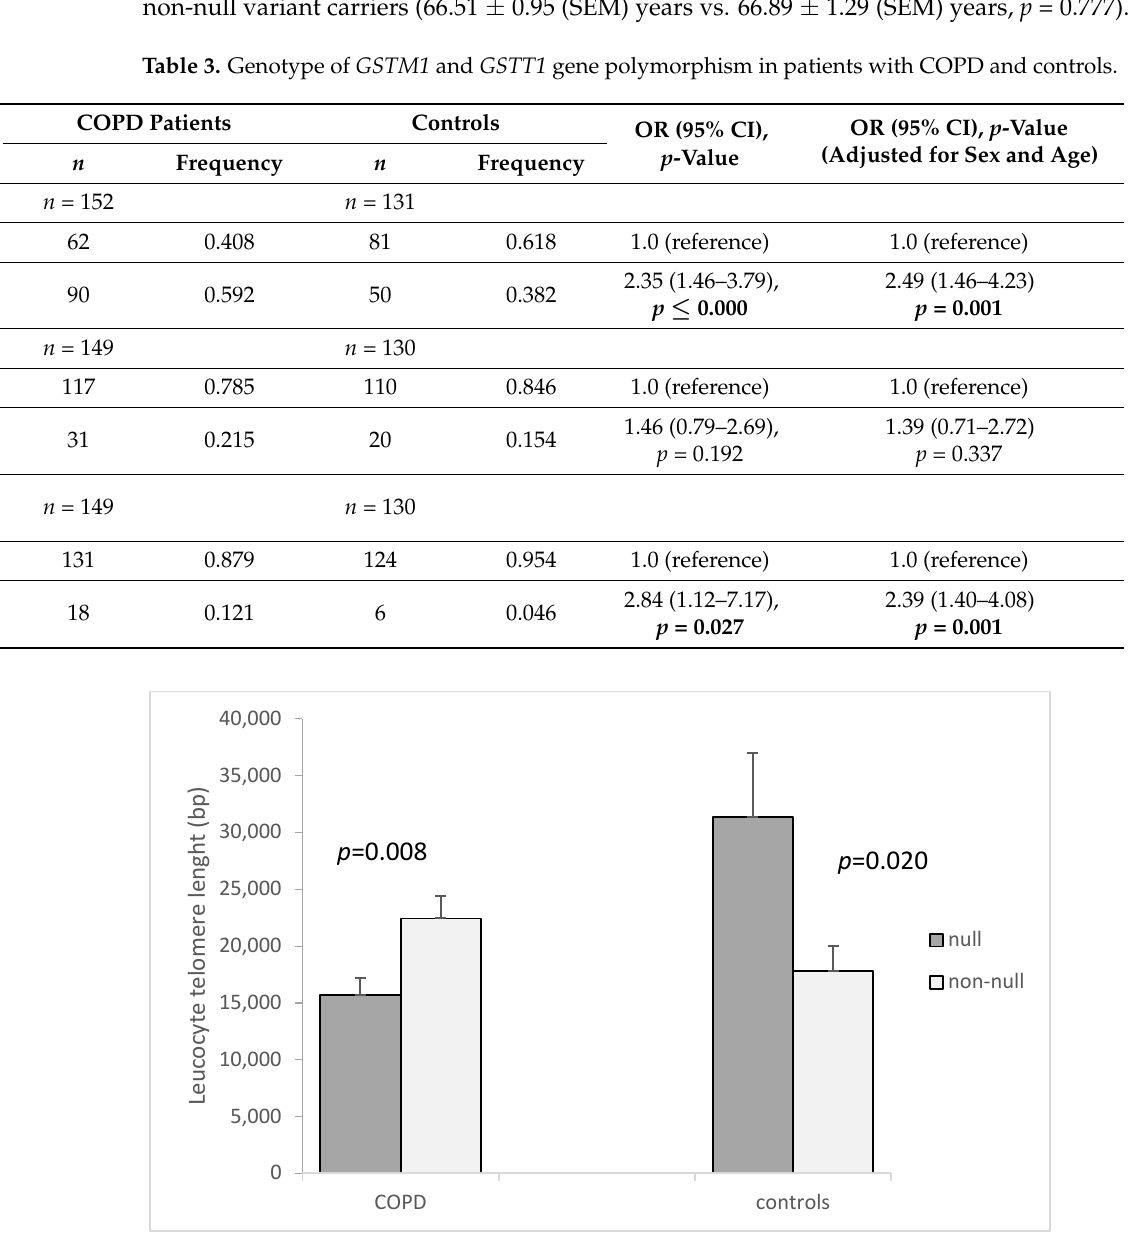
Figure 2. Leucocyte telomere length in COPD patients and controls according to presence of GSTM1 null variant. The LTL is presented as mean ± standard error of mean (SEM).